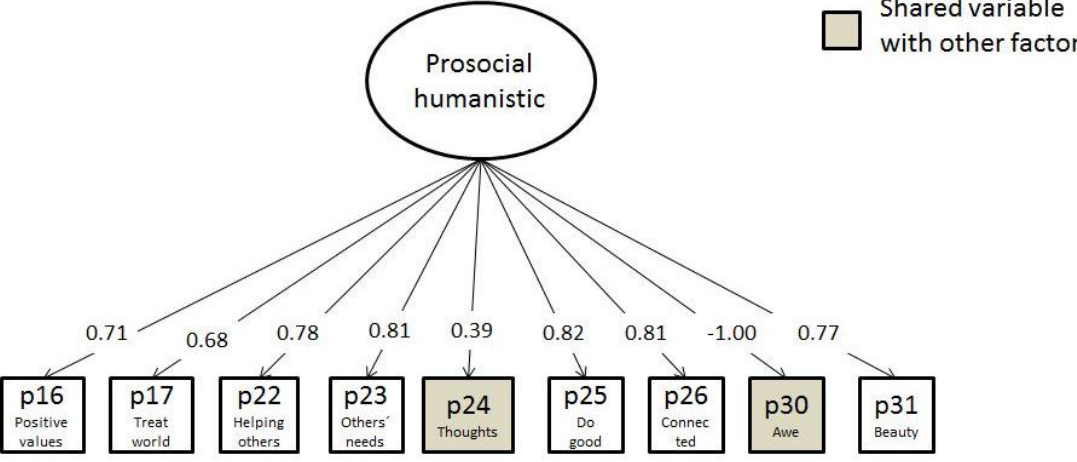
Figure 1. Factor Prosocial-humanistic practices from SEM.